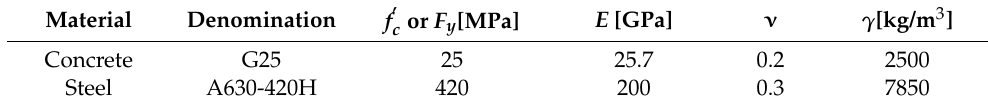
Table 2. Properties of concrete and reinforcement steel.